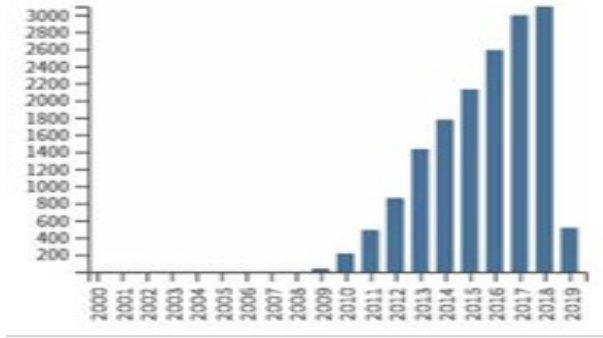
Figure 1-b. Total Publications by Year